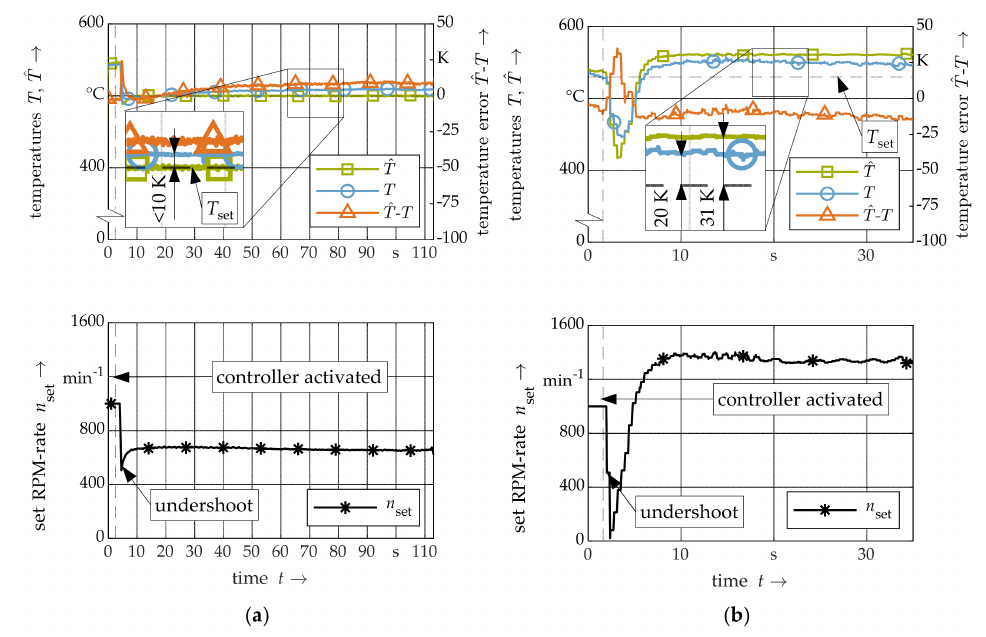
Figure 5. Validation of the complete control structure: Comparison of the measured temperature T (blue circle) to the calculated temperature ˆ T (green square) as well as the temperature model error ˆ T - T (orange triangle) and the set RPM-rate n set (black asterisk) for two bead-on-plate welds, exp. no. 11 without ( a ) and exp. no. 12 with ( b ) the application of a correction o ff set T corr ; the corresponding welding parameters are given in Table